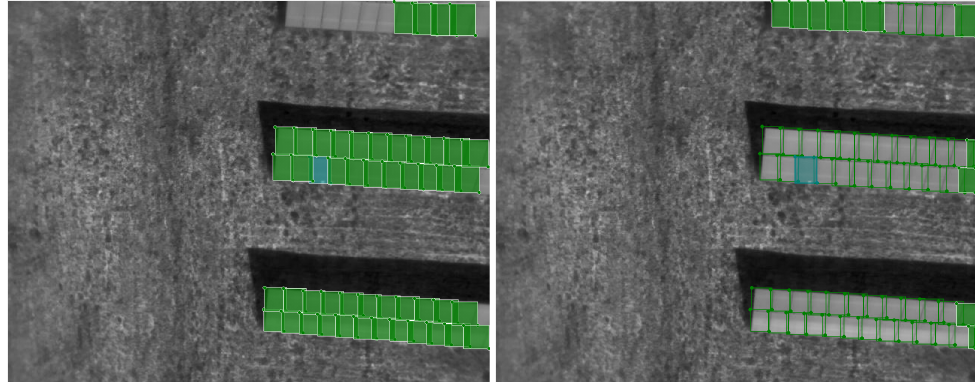
Figure 16. An example of the “mismatch” between the basic (“ground truth”) labeling (the left image) and the results of detection (the right image). The “false positive” shown in the right image with green color are PV modules that were not labeled in the base image because they are visible only partially. The reader should notice that the most interesting faulty module (shown in blue in the right image) was detected correctly in the right image (the blue box is visible there).